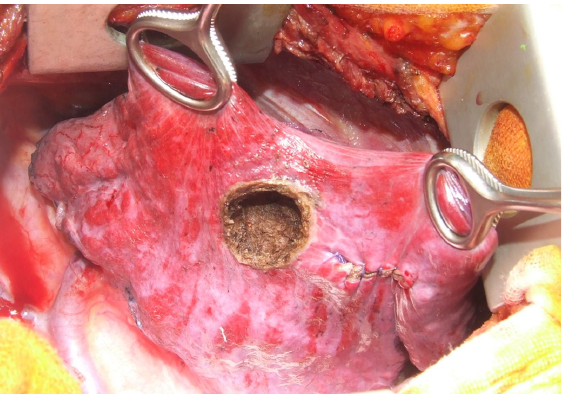
Figure 7. LASER pulmonary metastasectomies performed through open thoracic surgery. The lobectomy might be indicated in central or multiple lesions occupying the same lobe. Pneumonectomy should be avoided because it massively impairs respiratory func- tions and should be performed only in highly selected patients undergoing multidiscipli- nary team management [1,5]. In our study, we did not perform pneumonectomy for lung metastases. Lobectomy (Figure 8) or segmentectomy was performed in 11 patients—from which in two cases wedge pulmonary resections were added, and in another two cases other anatomical structures were removed (atrial and pericardial resection in one case, and parietal pleura in another case). Figure 8. Uniportal VATS right upper lobectomy for centrolobar metastasis—stapling the right up- per lobe venous drainage. VATS = Video-Assisted Thoracic Surgery. Wedge lung resections were performed in 47 patients—from which in four cases an additional resection was necessary: parietal pleura (for a pleural metastasis from breast cancer), splanchnic nerve, diaphragm + pericardium and, respectively, laser pulverization of multiple millimetric lung metastases (discovered intraoperatory). Some studies have reported better outcomes after typical resection (segmentectomy, lobectomy) [24,27]. The lower recurrence rate may be due to wider resection margins. The